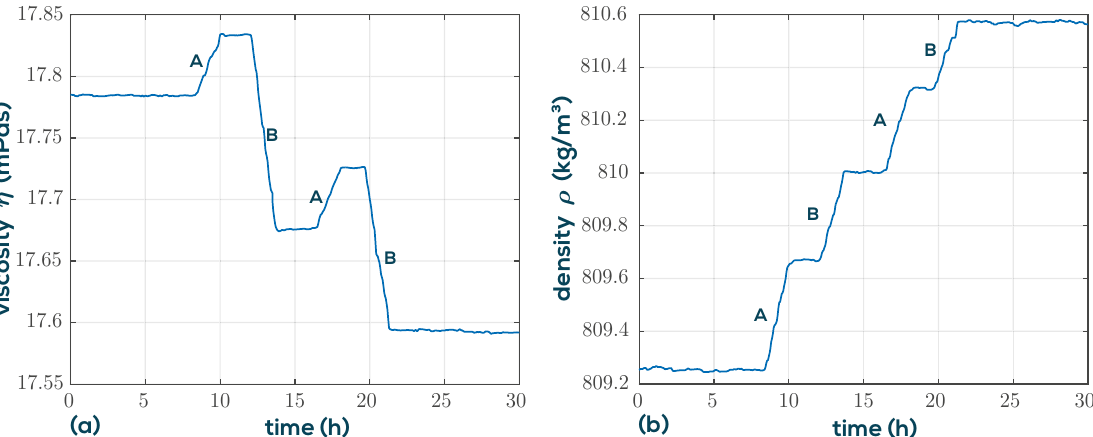
Figure 11. Viscosity ( a ) and density ( (b ) of engine oil for two different dilution scenarios A and B. Soot increases viscosity and density, but diesel reduces viscosity, as shown in Figure 10. Both scenarios introduce diesel and soot, but at different